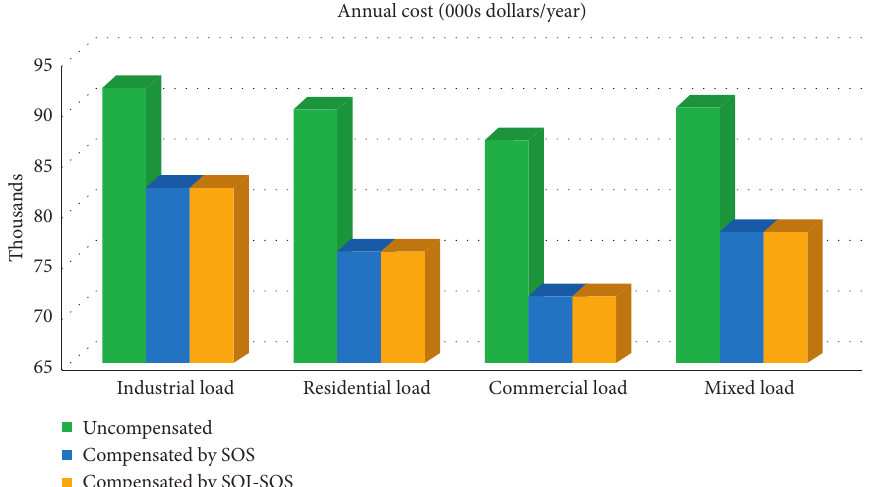
Figure 12: Annual cost of the 69-bus system before and after compensation with different load models.